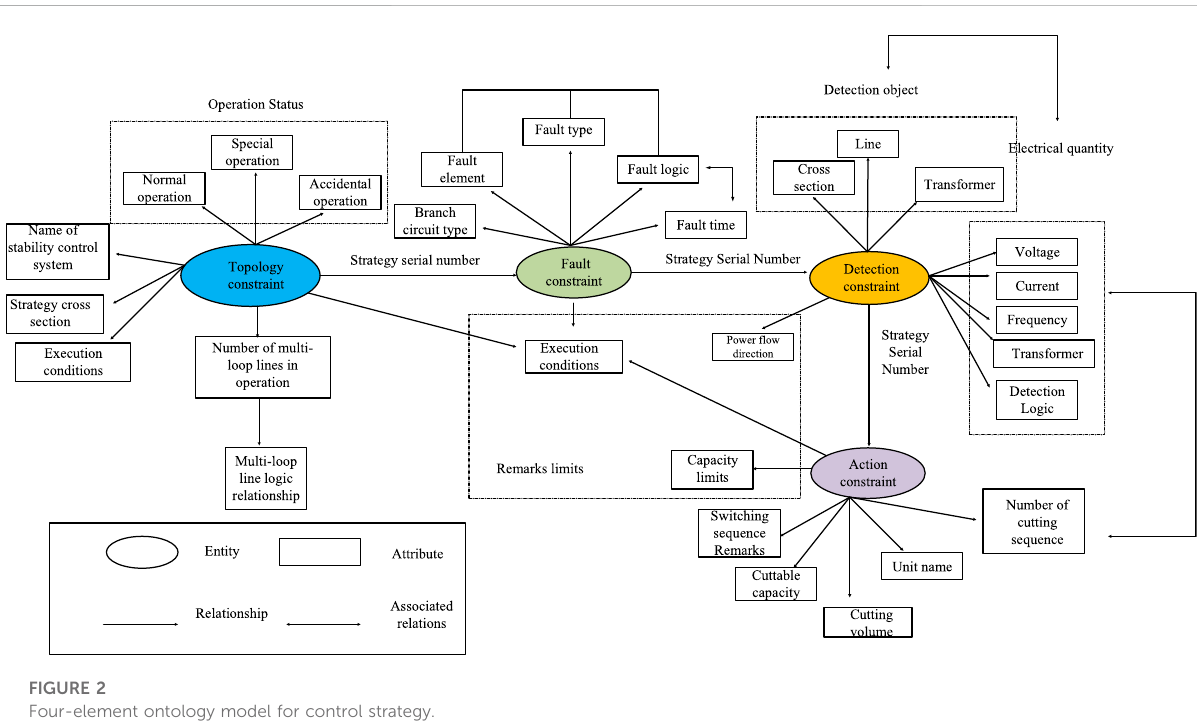
FIGURE 2 Four-element ontology model for control